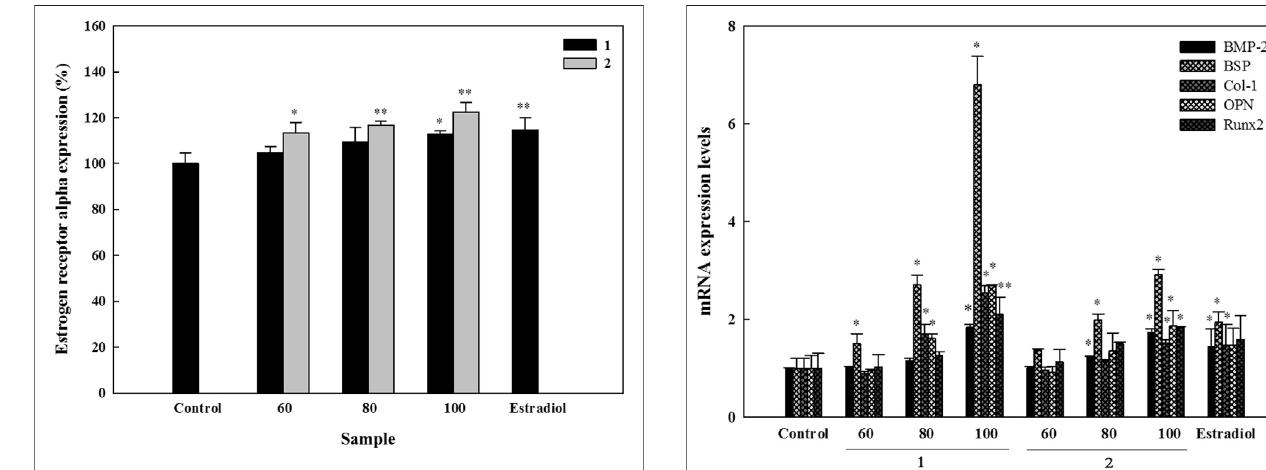
FIGURE4| Effectsofactivecompoundsontheexpressionofestrogen receptor (ESR)- α in human osteoblast cells. Cells were seeded in 96-well plates, and samples were added 24 h later. After fi ve days, expression of ESR- α was detected using an ELISA kit according to the manufacturer ’ s instructions. Experiments were carried out in triplicate. * p < 0.05 and ** p < 0.01; data are presented as the mean ± standard deviation. 1 , astragalin and 2 , kaempferol 3- O - β - D -apiofuranosyl-(1 → 6)- β - D -glucopyranoside.